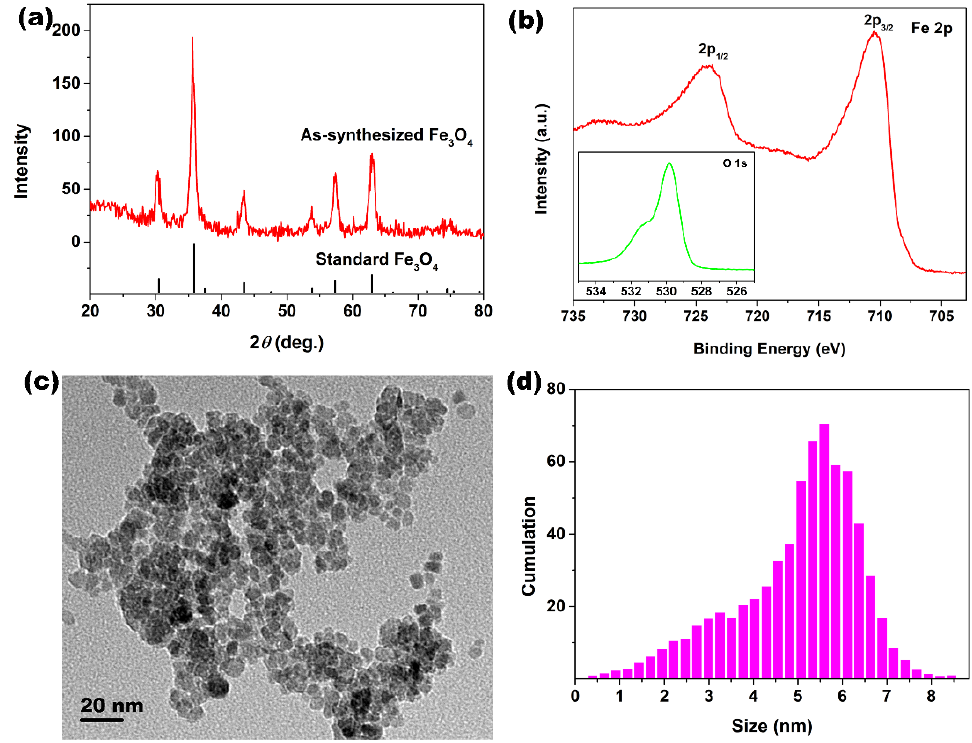
Figure 1. ( a ) XRD pattern of Fe 3 O 4 powders; ( b ) high–resolution XPS spectra of Fe 2p (the inset is the high–resolution XPS spectra of O 1s); ( c ) TEM image; and ( d ) size distribution histogram of Fe 3 O 4 particles.